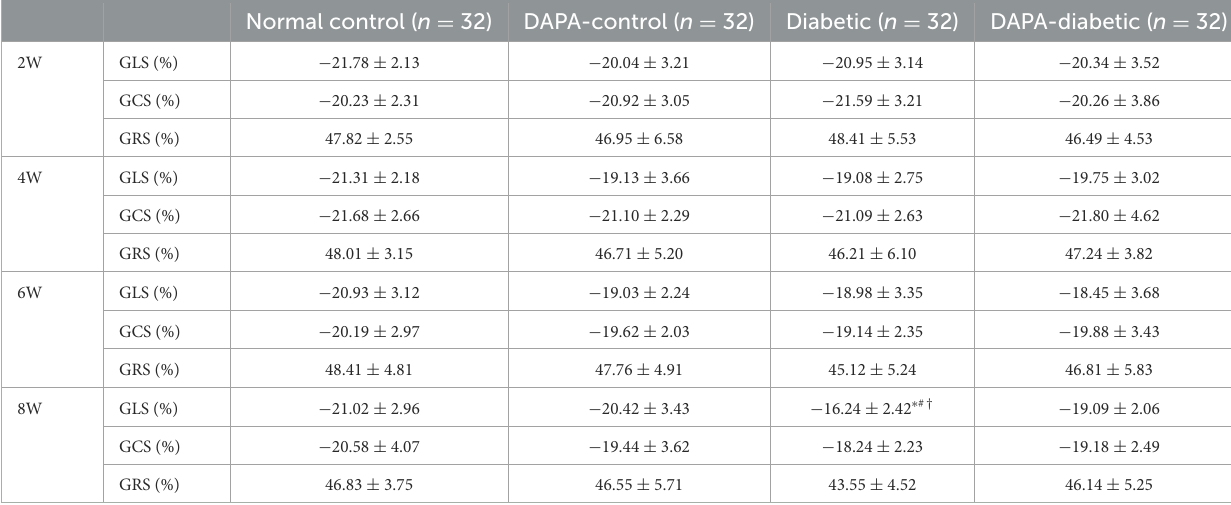
TABLE 2 Left ventricular strain data by